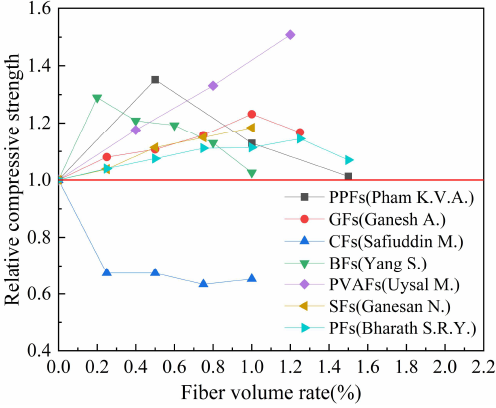
Figure 11. The effect of fiber type on compressive strength.